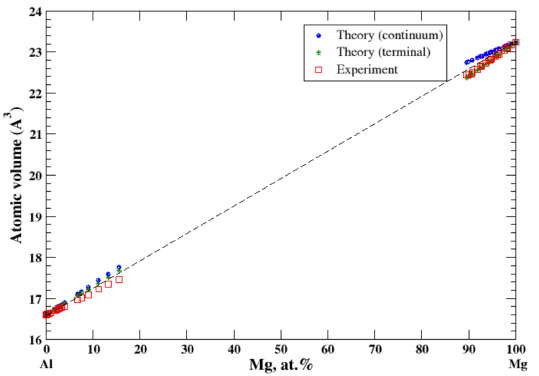
Figure 3. Atomic volume vs. concentration for Al-Mg alloy system. The experimental data are from Ref. [16] (p. 367 and p. 728).